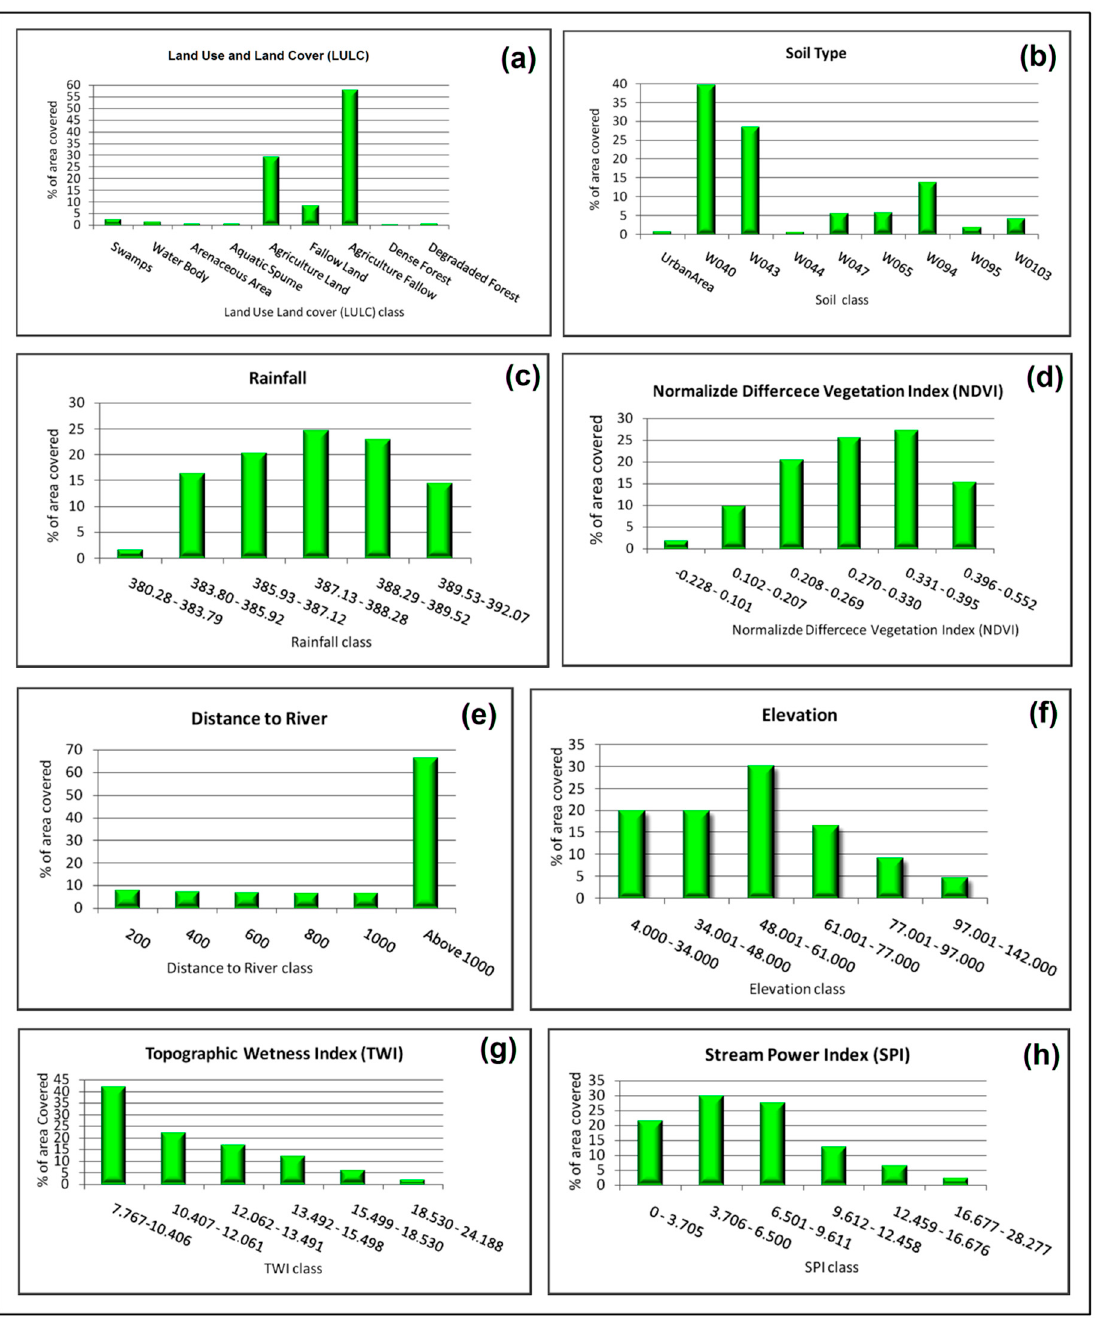
Figure 5. Percentage of area of respective flood causative factors; ( a ) LULC, ( b ) soil type, ( c ) rainfall, ( d ) NDVI, ( e ) distance to river, ( f ) elevation, ( g ) TWI, and ( h ) SPI.